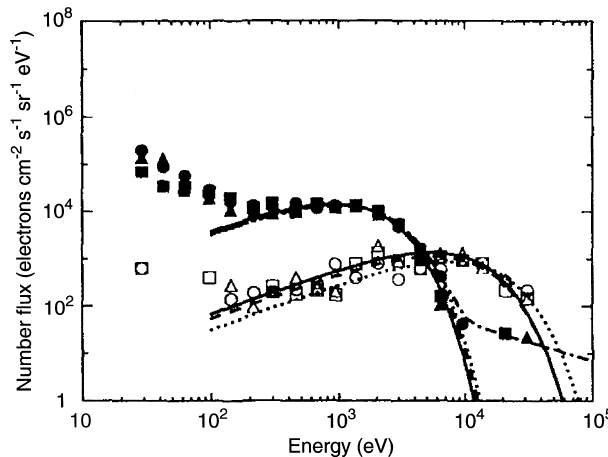
Fig. 1. Particle spectra near the time of the conjunction on December 5, 1994. Triangles show measurements at 19:11:36 UT. Circles are for 19:11:37 UT and squares for 19:11:38 UT. Open symbols show the ion precipitation and solid symbols the electrons. A Maxwellian fit has been performed for both particle spectra, and the electron spectrum exhibits a high energy tail (Anderson et al ., 1997)